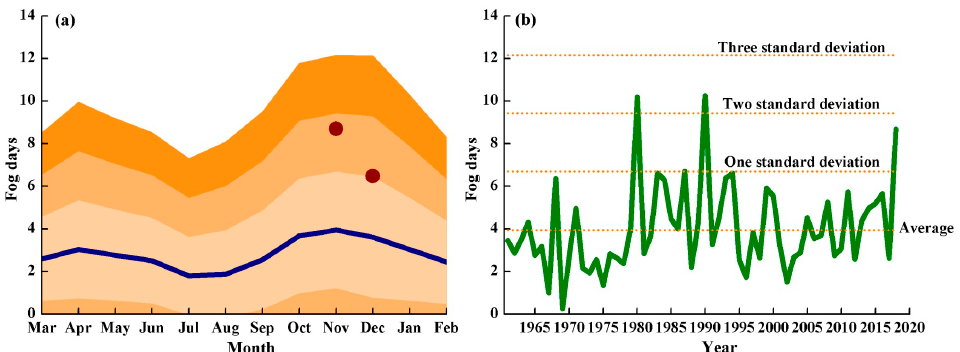
Figure 3. ( a ) The climatological annual cycles of fog days (dark blue line) averaged from 1961 to 2017 over Jiangsu Province in China (the boundary of is Jiangsu Province marked in Figure 2c). The filled lines from light orange to dark orange represent ±1, ±2 and 3 standard deviations among the measured sites. The red solid circles mark the fog days of November and December in 2018. ( b ) The interannual variations of fog days in November averaged over Jiangsu Province in China from 1961 to 2018. The four dotted lines denote the average fog days and the fog days of one to three standard